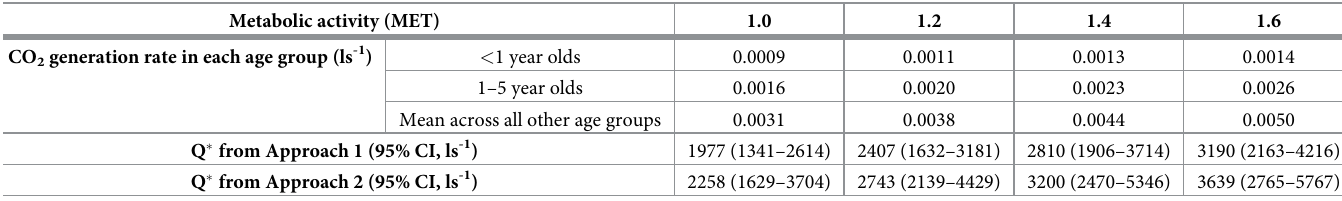
Table 4. Carbon dioxide generation rate (ls -1 ) in each age group for each level of metabolic activity (MET [17]). Metabolic activity